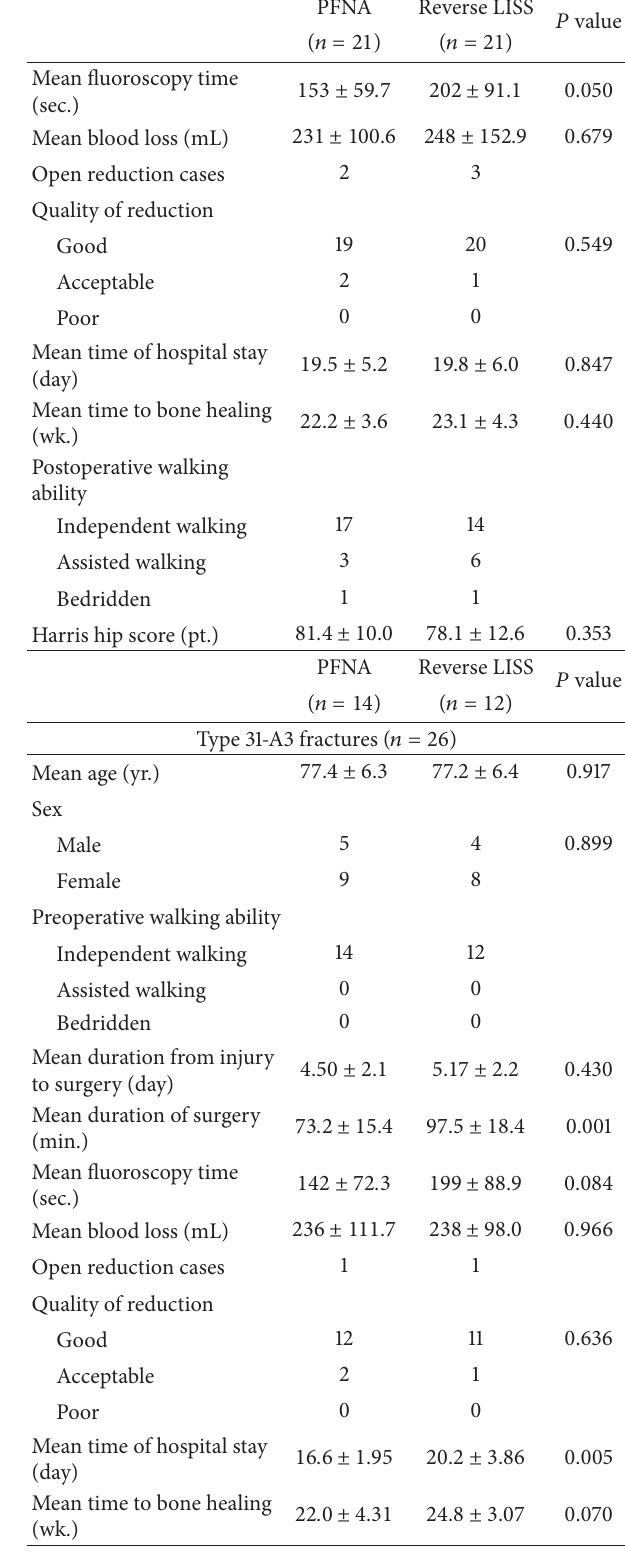
Table 1: Main demographic and clinical data of the fractures by treatment